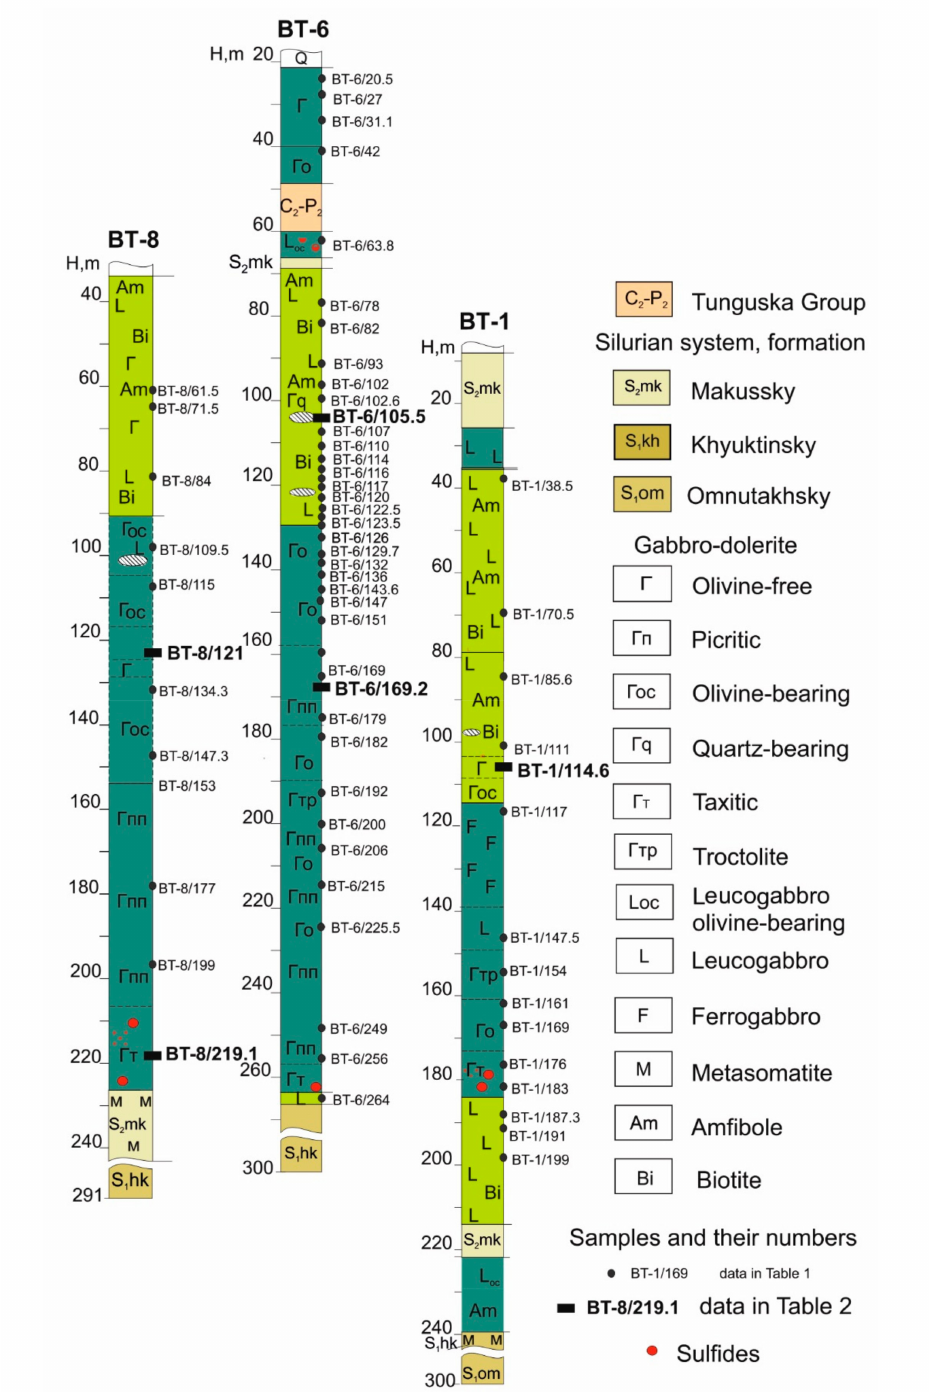
Figure 3. Inner structure of the intrusive bodies in the boreholes BT-1, BT-6 and BT-8, and the relative location of the studied samples. The mineral composition of gabbro-dolerite is indicated by letter symbols in the lower right